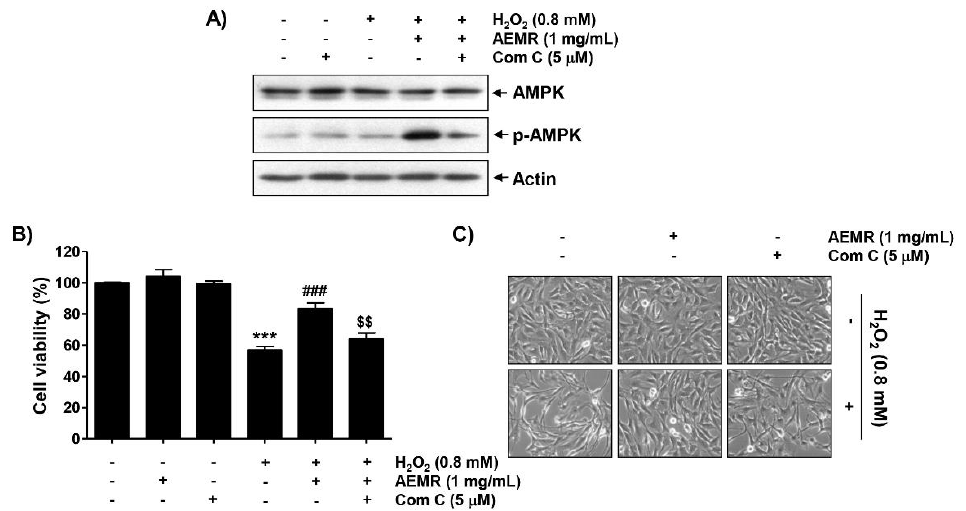
Figure 3. Effects of AMPK inhibitor, compound C, on AEMR-mediated protection of growth inhibi- tion by H 2 O 2 in C2C12 cells. Cells were pretreated with 5 μM compound C (Com C) with or without 1 mg/mL AEMR for 1 h, and then subjected to treatment with 0.8 mM H 2 O 2 for 24 h. ( A ) Expression of AMPK and p-AMPK was measured by western blot analysis. Anti-actin immunoblotting revealed relative amounts of protein in each lane. ( B ) Cell viability was evaluated using an MTT assay. Data are presented as mean ± SD from triplicate experiments (*** p < 0.001 vs. control cells; ### p < 0.001 vs. H 2 O 2 -treated cells; $$ p < 0.001 vs. H 2 O 2 and AEMR-treated cells). ( C ) Morphological changes were observed with a phase-contrast microscope.